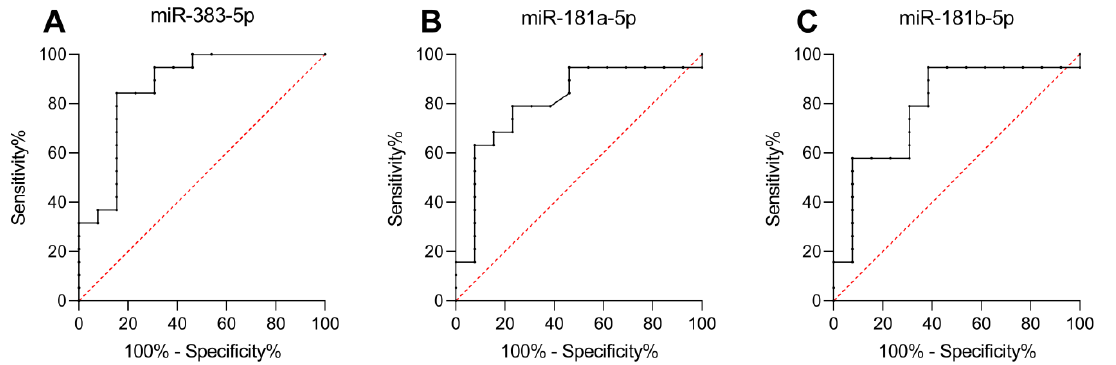
Figure 4. miR-383-5p, miR-181a-5p, and miR-181b-5p are predictors of response. ROC curve of differentially expressed miRNAs that correlated with responsiveness. ( A ) miR-383-5p ROC curve with p = 0.005. ( B ) miR-181a-5p ROC curve with p = 0.019. ( C ) miR-181b-5p ROC curve with p = 0.027.